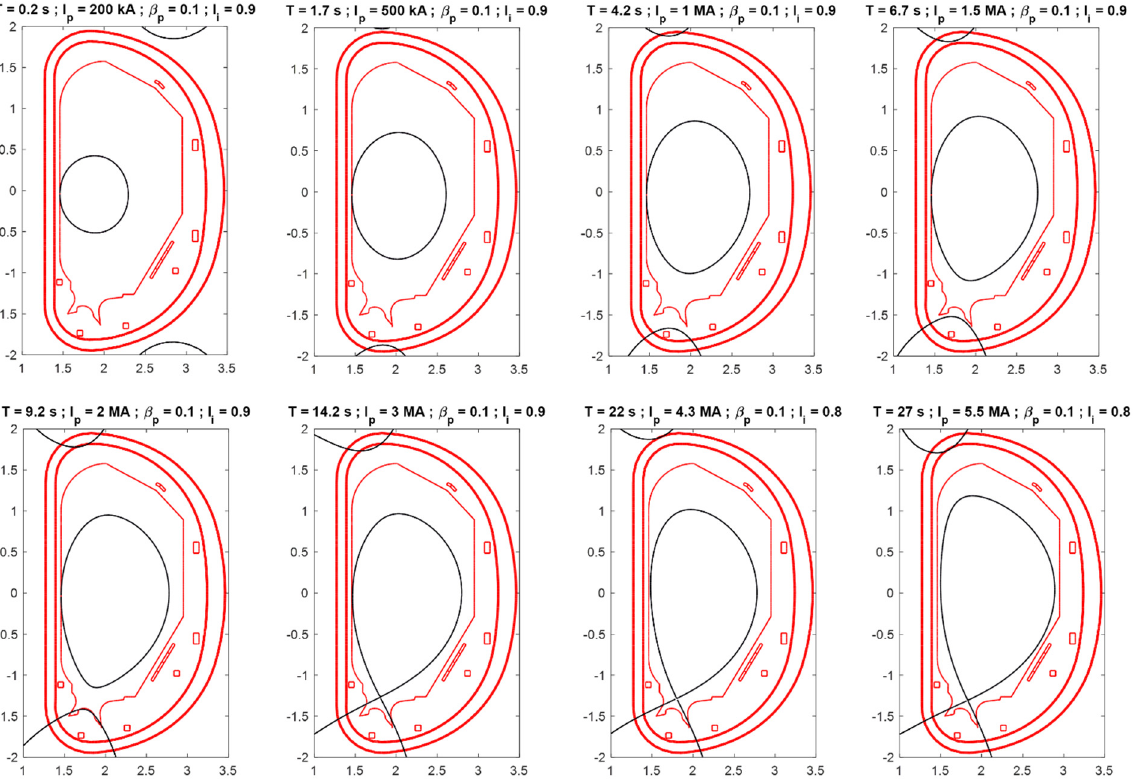
Figure 3. Time evolution of plasma shapes of the DTT ramp-up phase with a plasma current rate equal to 200 kA/s.